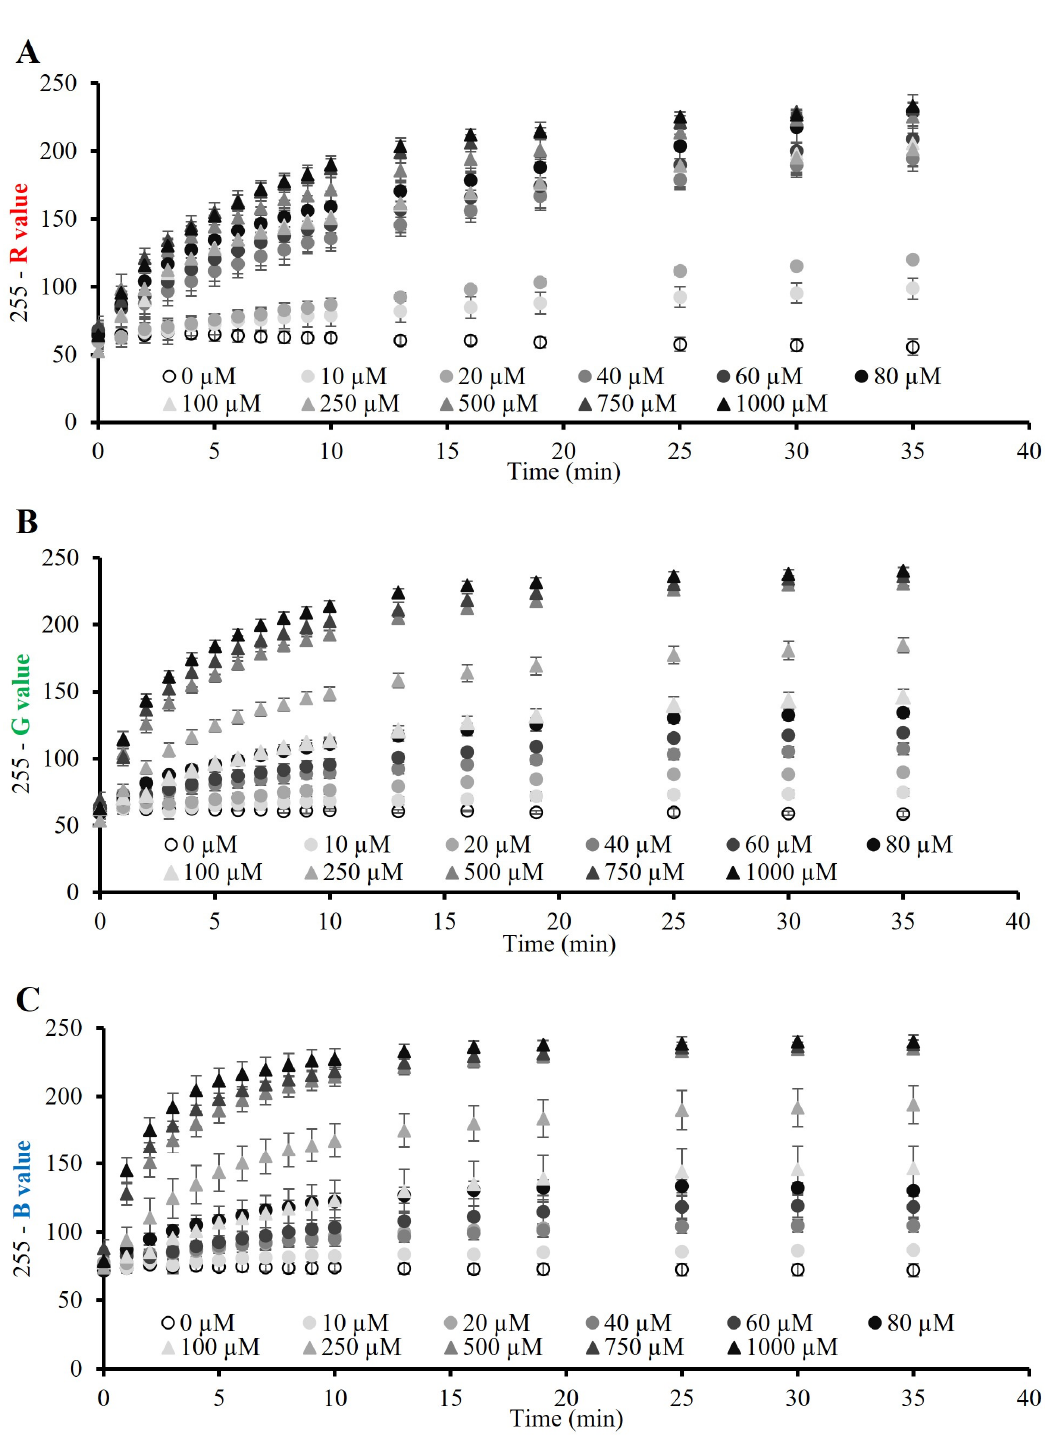
Figure 3. RGB analysis of the alginate beads for glucose sensing. ( A ) Red (R), ( B ) green (G) and ( C ) blue (B) values of the beads for glucose 10–1000 μ M in the alginate biosystem for 40 min (n = 4). 3.3. Calibration and Verification of the Alginate Biosystem for Glucose Sensing in Plate